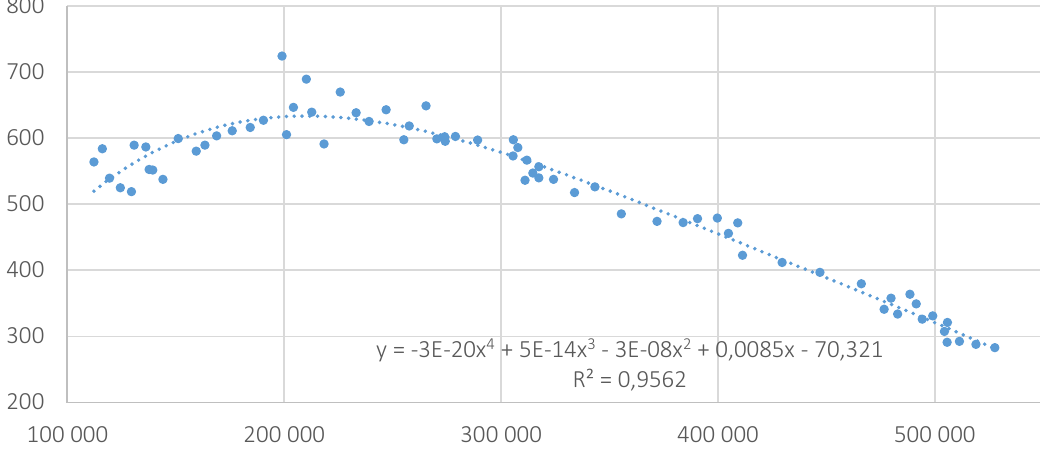
y = -3E-20x 4 + 5E-14x 3 - 3E-08x 2 + 0,0085x -